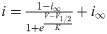
Inactivation of low-voltage activated Ca2+ currents.A) 100 ms long pre-pulse to -20 mV inactivates Ca2+ current that peaks at –20 mV (tracings a) but not the one that peaks at +30 mV (tracings b). B) Voltage-dependence of inactivation of low- (filled circles) and high- (open circles) voltage- activated Ca2+ currents (n = 3). The smooth lines are the best fits by equation i=1−i∞1+eV−V1/2K+i∞.